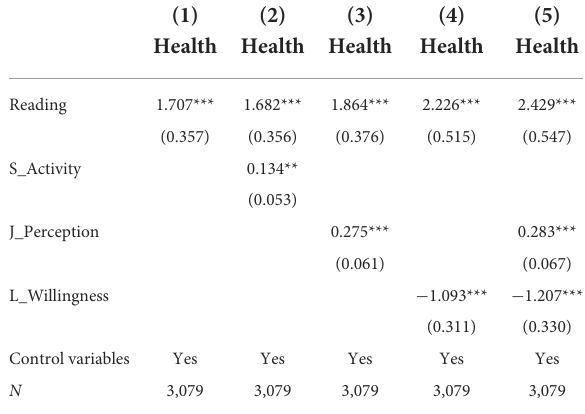
TABLE 4 Impact mechanism test